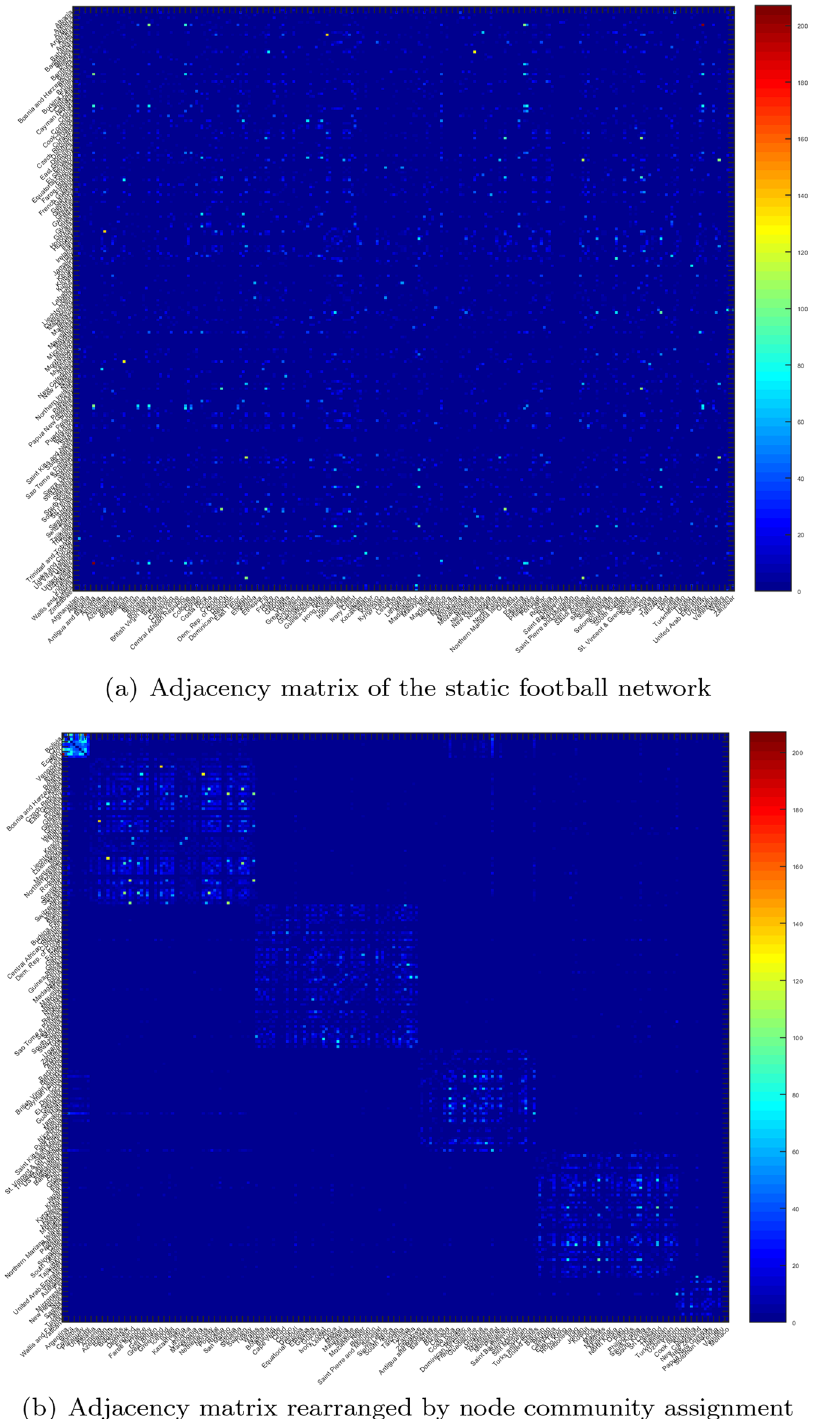
Fig. 6 Adjacency matrix before and after community detection. a the original adjacency matrix of the representative network from 1872 to 2016; b the adjacency matrix in which the nodes are rearranged by their community